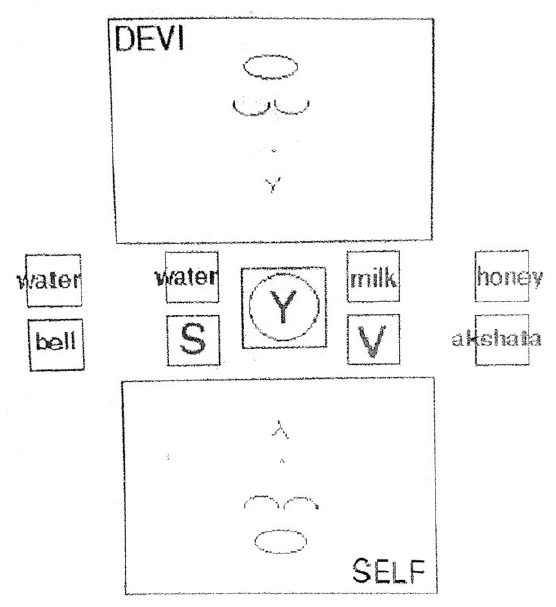
Figure 8. K ā makal ā set-up. Credit: Saraswati (2016, p. 24). Figure 8. K¯amakal¯a set-up. Credit: Saraswati (2016, p.